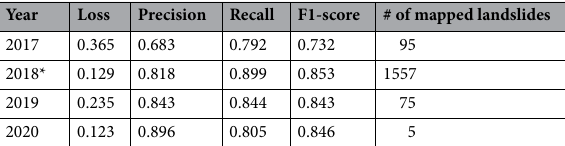
Table 3. Accuracy of mapped landslides in time in Porgera, Papua New Guinea. *Co-seismic event